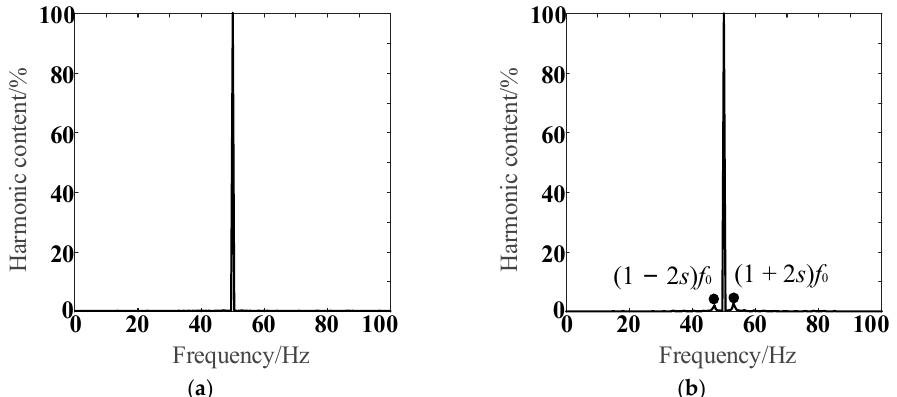
Figure 2. The fusion correlation spectrums of current signal and radial electromagnetic force signal. ( a ) Normal motor; ( b ) faulty motor with broken rotor bars.